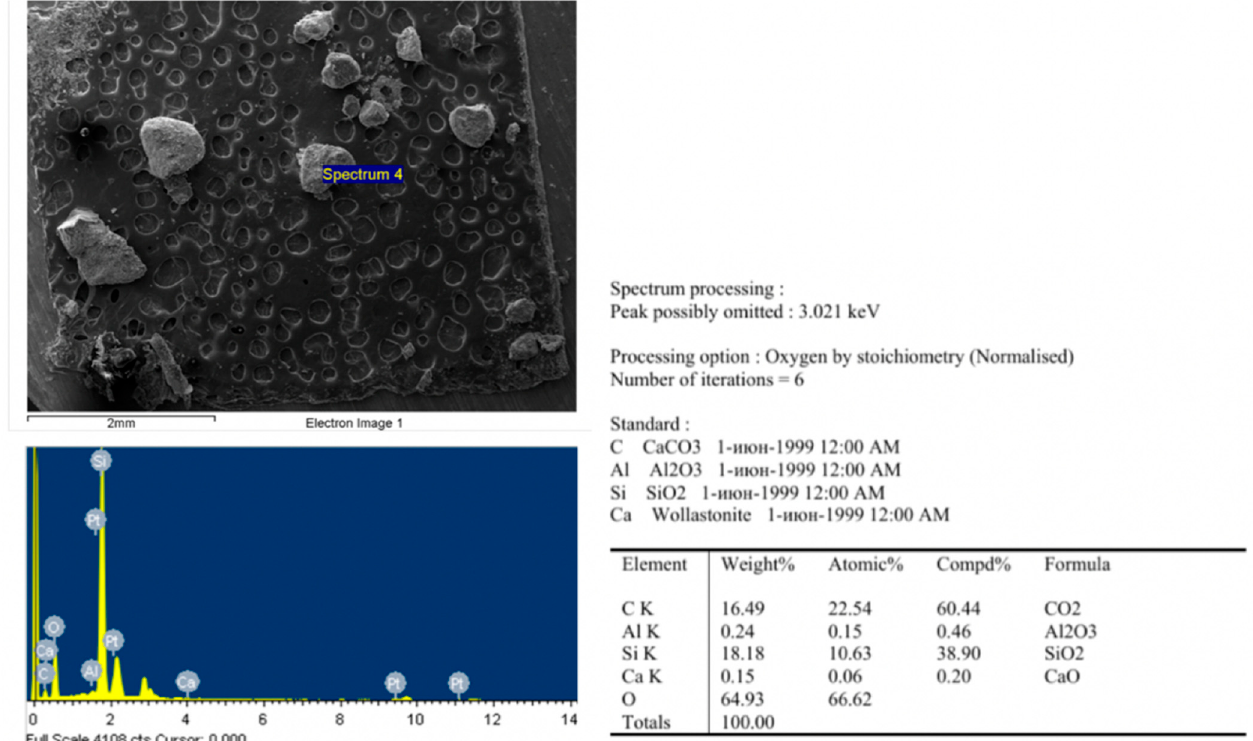
Figure 4. Energy dispersive spectrum of quartz grain. SAM LEO 1450 VP, Carl Zeiss.